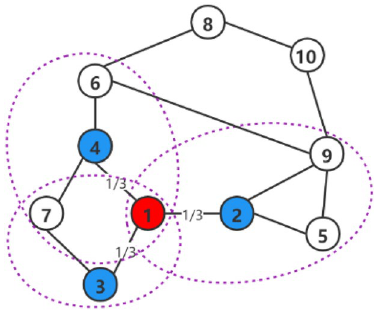
Figure 1. Diffusion network. Red node 1 represents the source node, blue node is the domain node of node 1, and each dotted box represents the domain of the blue